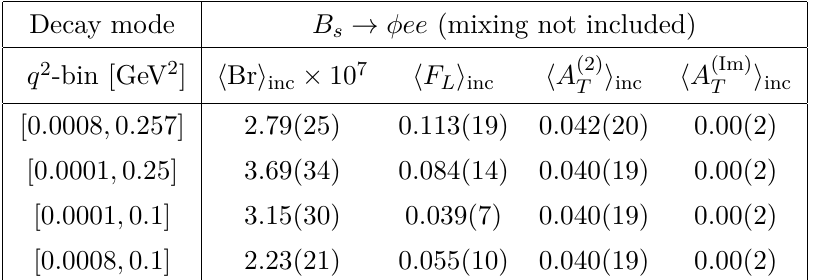
SM predictions for B observables without including the effect of mixing in s → φee the low- q 2 region. Note that the branching fraction corresponds to the sum of Br( B Br( B ) . s → φee